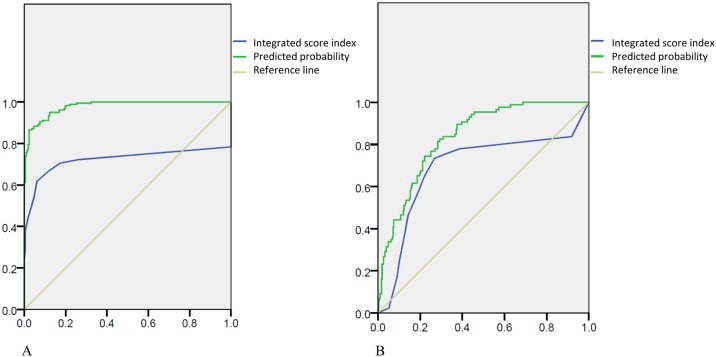
(A) Use of the integrated score index and predicted probability to discriminate any diastolic dysfunction (U.S. grades 1, 2, and 3) in the healthy population. Predicted value AUROC: 0.979; integrated score index AUROC: 0.722 (blue line: integrated score index; green line: predicted probability; yellow line: reference line). (B) Use of the integrated score index and predicted probability to discriminate moderate to severe diastolic dysfunction (U.S. grades 2 and 3) in the healthy population. Predicted value AUROC: 0.835; integrated score index AUROC: 0.692 (blue line: integrated score index; green line: predicted probability; yellow line: reference line).